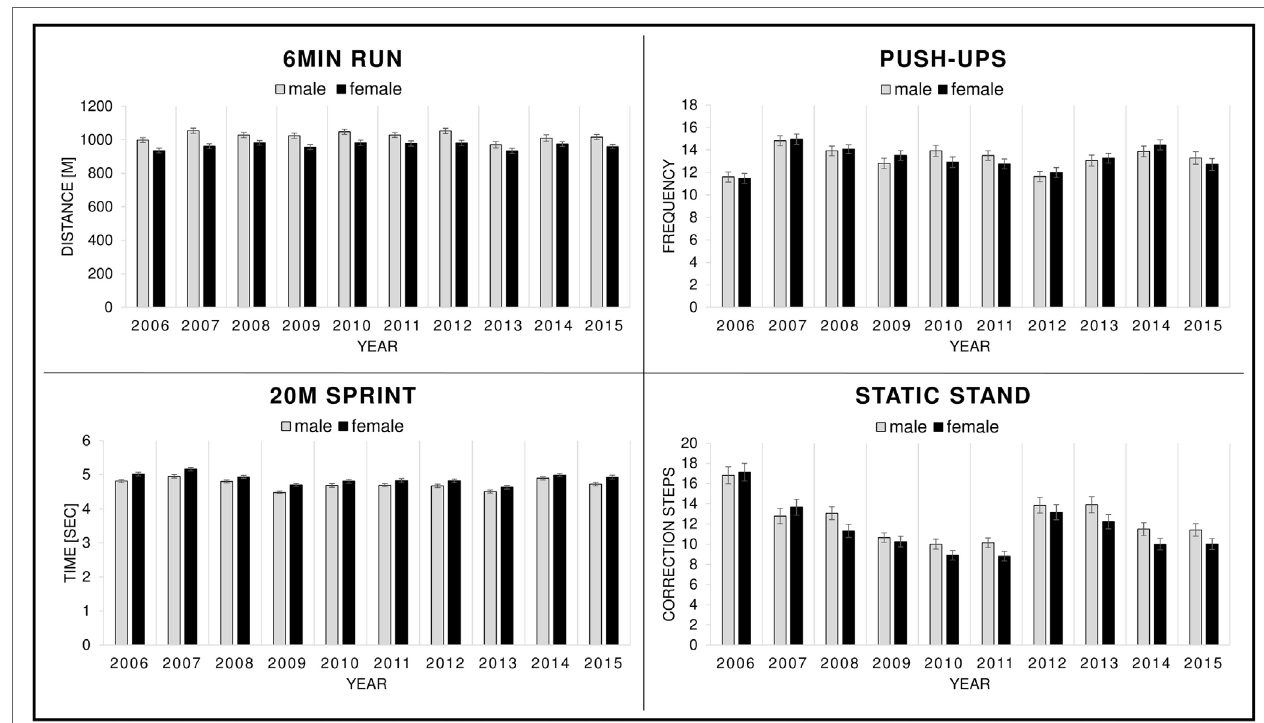
FigUre 1 | Mean values of the motor performance tests from 2006 to 2015 for boys and girls